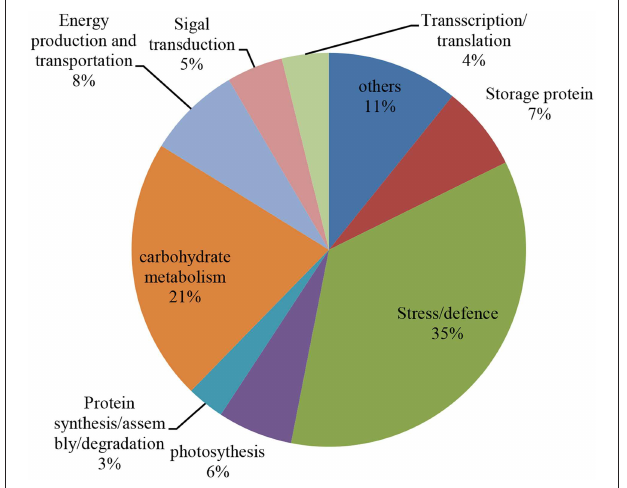
FIGURE 4 | Distribution of the proteins that were identified during four grain development stages in Yunong 201 and Yunong 3114. Nine protein groups were categorized based on their putative functions.